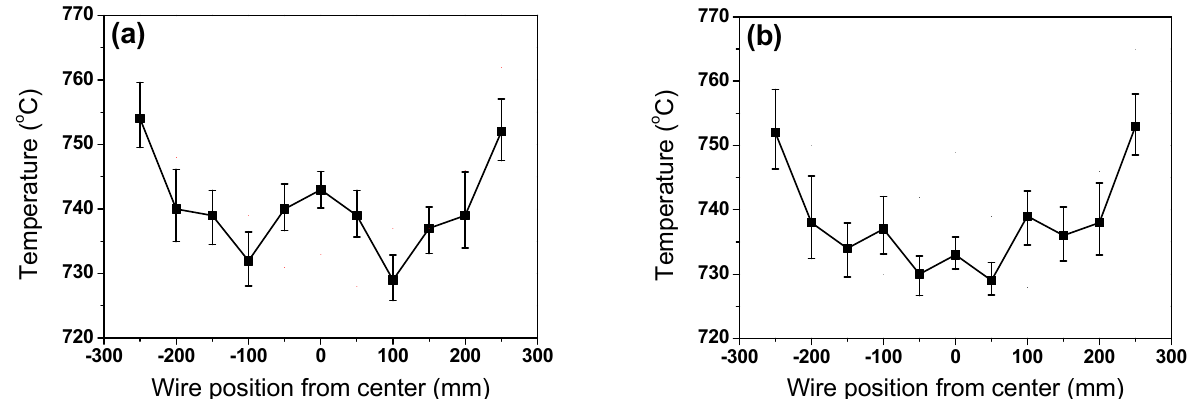
Figure 8. Comparison of measured temperatures of wire ring along TD wr with ( a ) inline and ( b ) staggered arrangements in the Stelmor simulator.